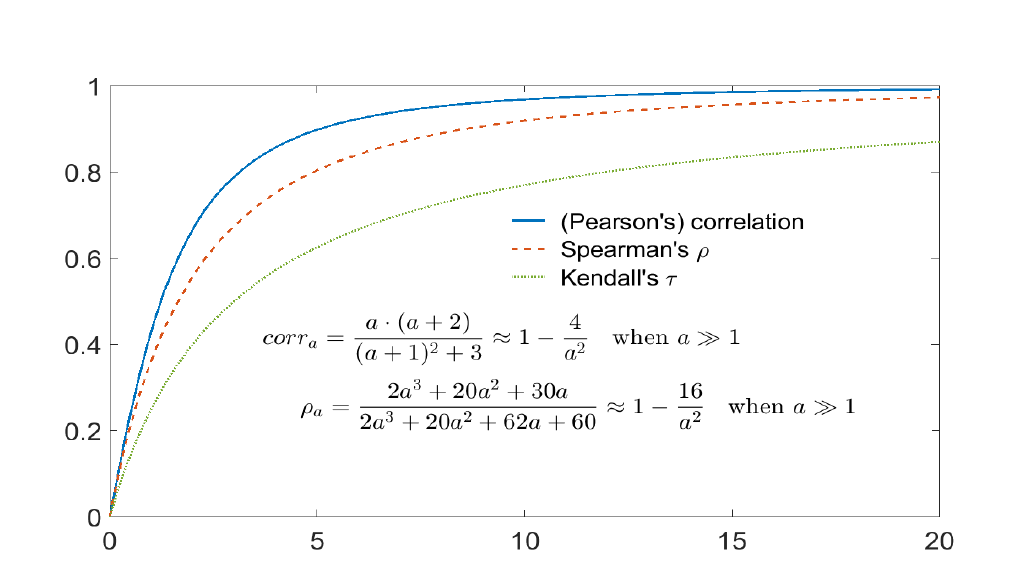
Figure 5: Three usual correlation coefficients for ( X 1 , X 2 )